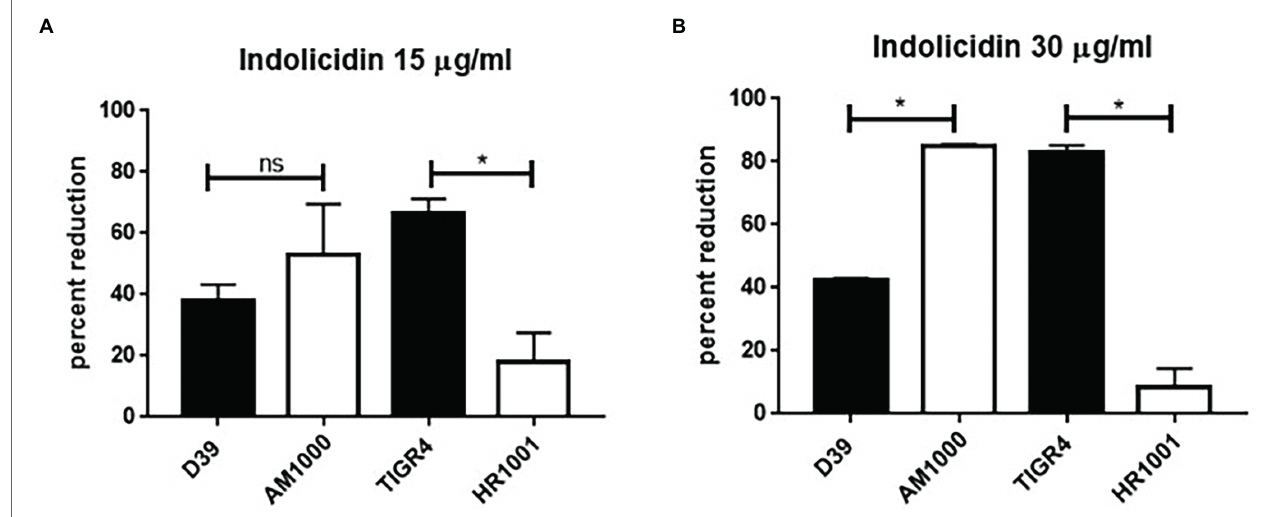
FIGURE 3 | Capsule affects pneumococcal resistance do indolicidin. Wild-type pneumococcal strains D39 (serotype 2) and TIGR4 (serotype 4) and their capsule- negative mutants AM1001 (D39 background) and HR1001 (TIGR background) were treated with indolicidin at 15 μ g/ml (A) and 30 μ g/ml (B) and plated. The percent reduction in bacterial survival is shown for each group. Statistical analysis was performed using Student’s t -test. * p < 0.05 in comparison with the wild-type strain; ns, not